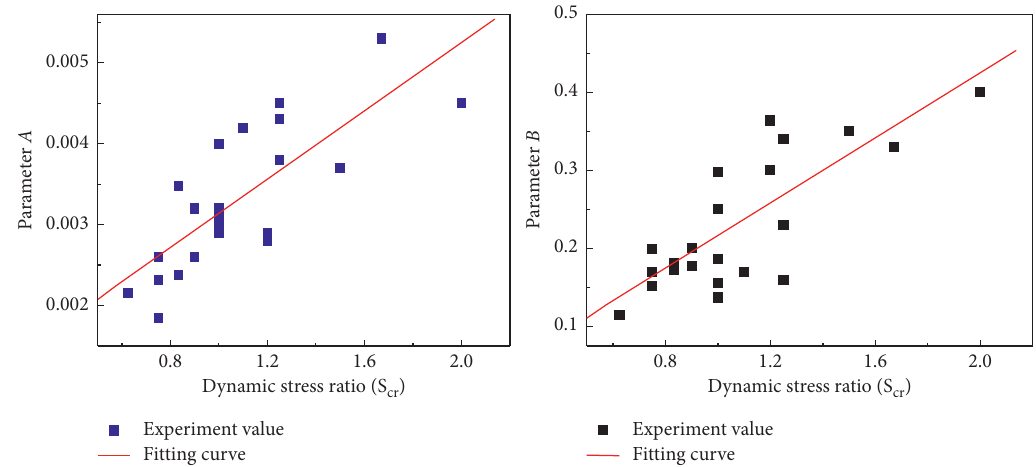
Figure 8: Parameters A and B vs. dynamic stress ratio S